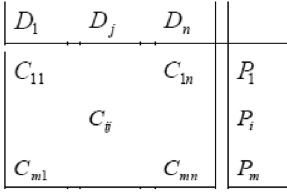
Figure 3. Subjective objective system for generating optimal product concepts (reference: Ziv-Av and Reich).